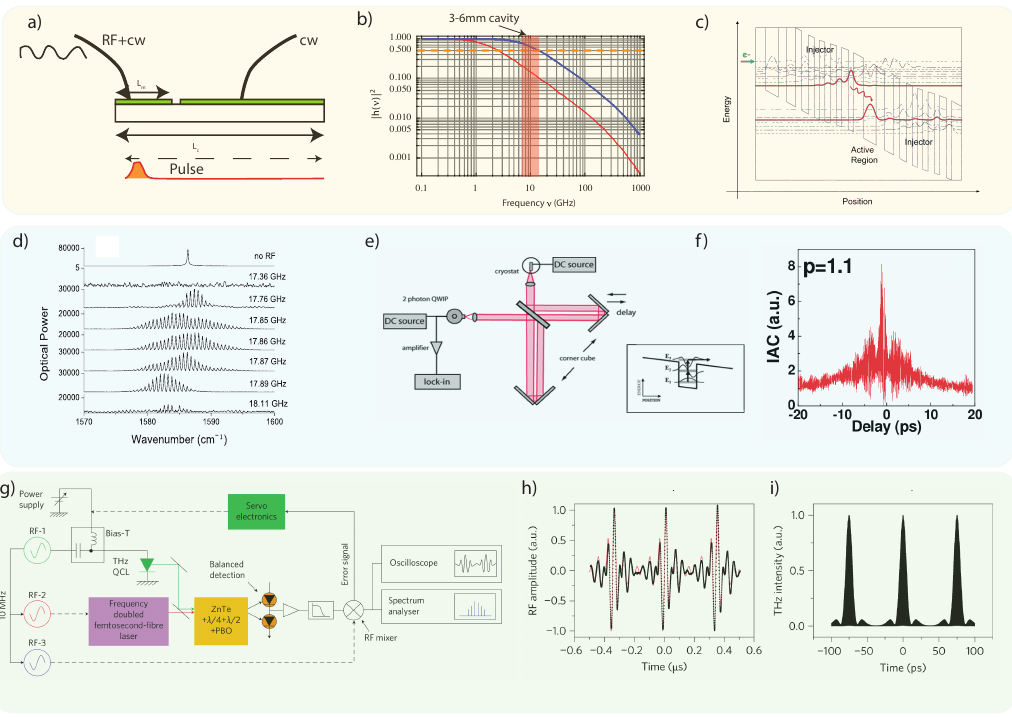
Figure 3: Mode-locking QCLs. a Schematic diagram of an actively mode-locked QCL: the modulated section opens a window in time, allow- ing a single pulse to propagate in the cavity. b The computed transfer function of a QCL close to threshold (red solid line) and at twice the threshold (blue solid line), showing the high modulation capability at frequencies corresponding to the round-trip frequency of a 3–6mm cavity laser. Results published in [27]. c Active region based on a photon-assisted tunneling transition, with very long upper state lifetime. Results published in [37]. d Spectrum of the device presented in c under modulation. e Interferometric autocorrelation technique: the opti- cal pulses are characterized by Fourier Transform Interferometer followed by a two-photon quantum well photodetector. f The resulting in- terferogram, measured 10% above threshold, shows the ratio of 8:1 between the center and the wings, expected for single pulses.